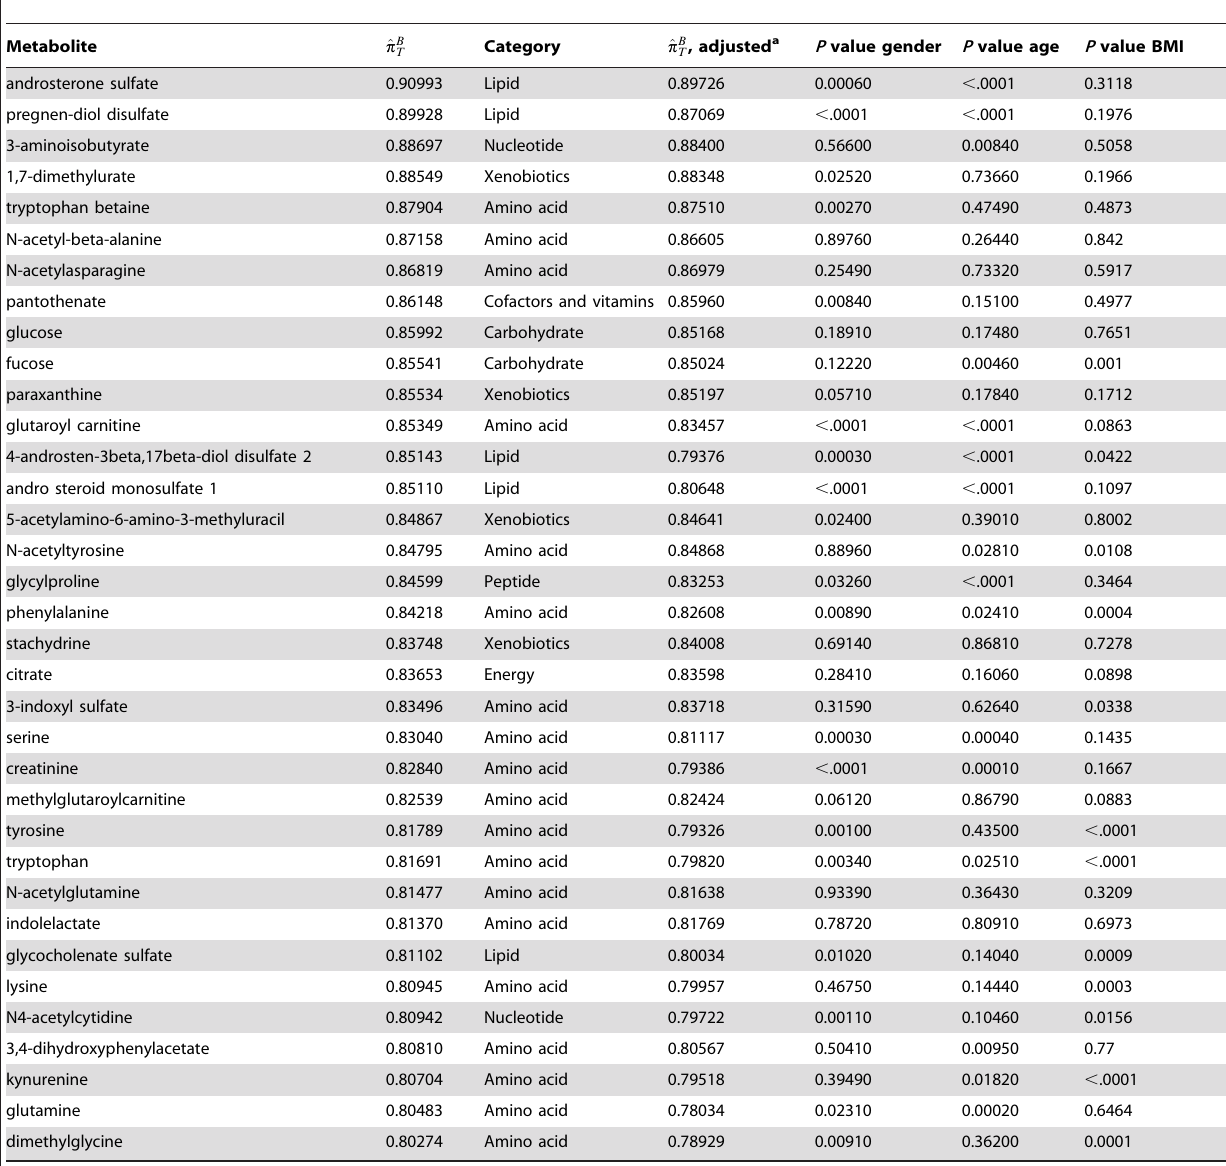
Table 2. A list of identified metabolites with the highest values of between subject variability, ^ pp B variability), among all metabolites in the Navy Colon Adenoma